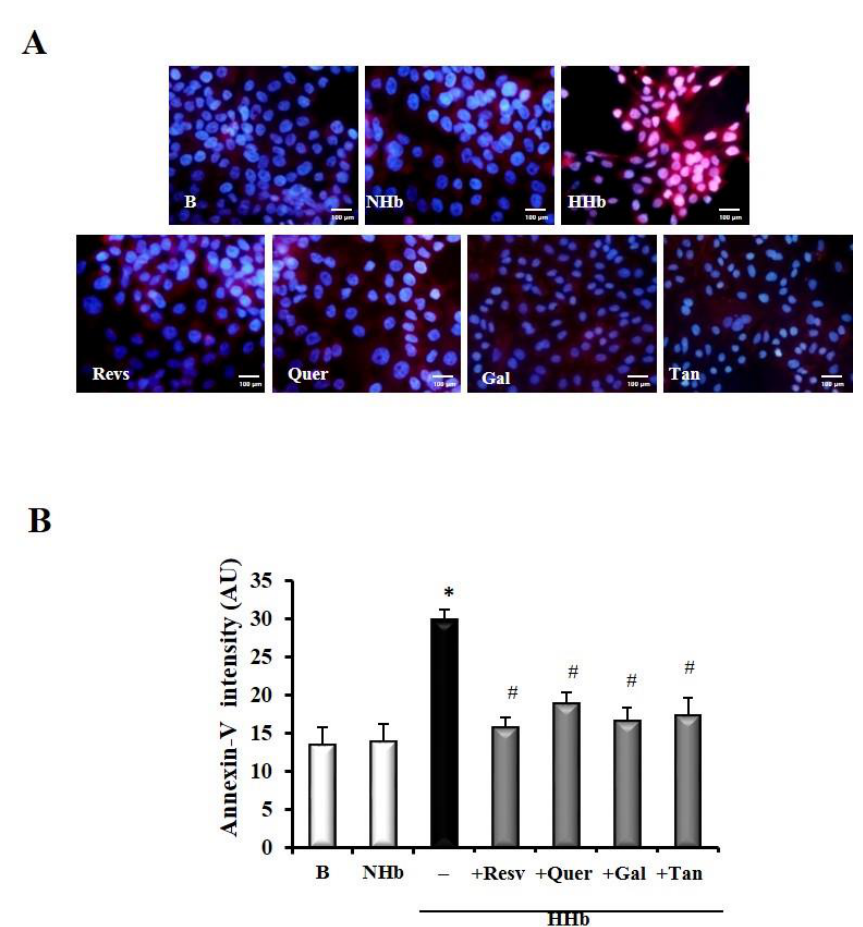
Figure 4. Levels of annexin V decreased associated with Polyphenols treatment in HPMC. ( A ) Representative immunostaining of annexin V in HPMCs. The cytoplasm shows annexin-positive staining (red) characteristic of apoptotic cells ( × 40). Scale bar 100 µ m; ( B ) Quantification of fluorescence intensity for Annexin-V. Cells exposed for 24 h to different Amadori adducts, HHb and NHb (10 nM), polyphenols: resveratrol (Resv, 12.5 µ M), tannic acid (Tan, 10 µ M), quercetin (Quer, 10 µ M), gallic acid (Gal, 10 M). For each experiment, 10 independent cultures of HPMCs were used, corresponding to 10 donors. Data represent means ± SD of 7 independent experiments (for each culture of HPMCs corresponding to each of the 10 donors), B) in Arbitrary units (AU), *p≤ 0.05 vs. el basal. #p≤ 0.05 vs. HHb.